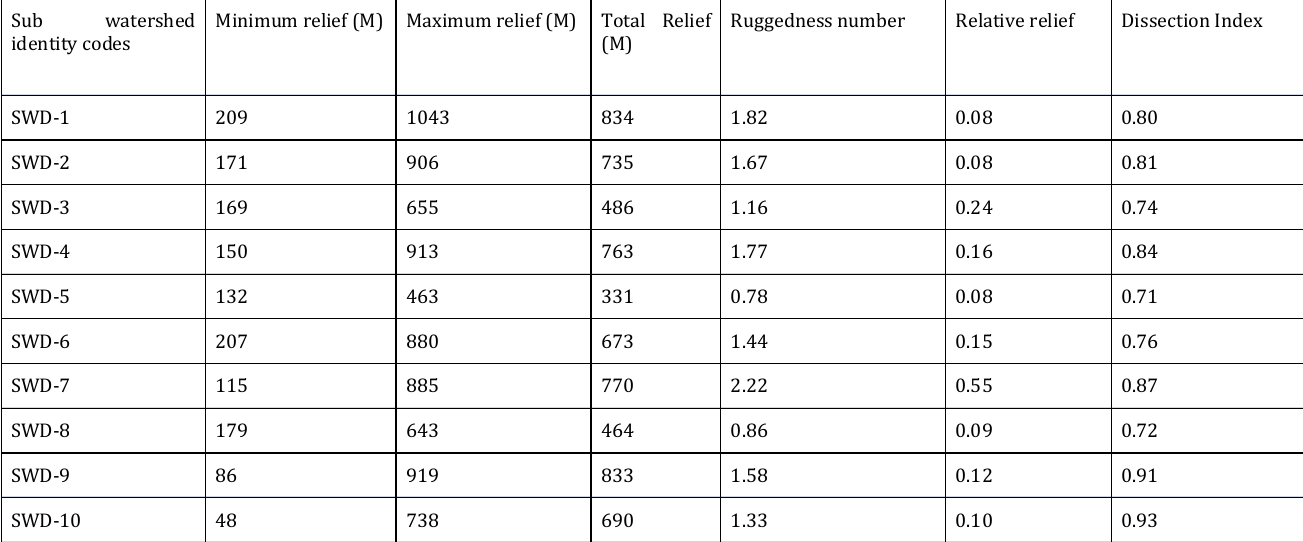
Table 10: Relief aspect of upper watershed of river Subarnarekha